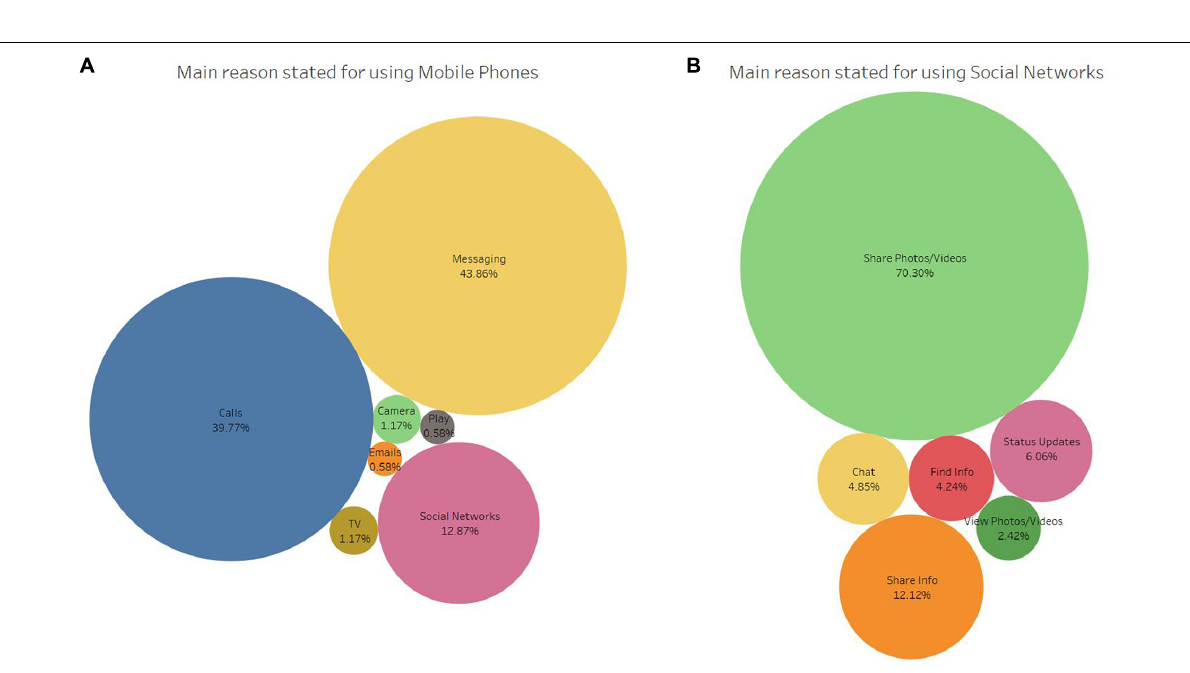
Frontiers in Psychology |